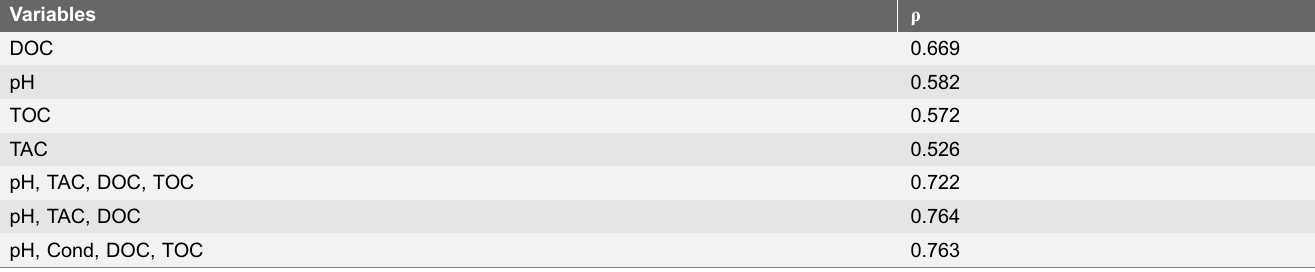
Table 4. Results from BIO-ENV analyses of bacterial community composition and environmental